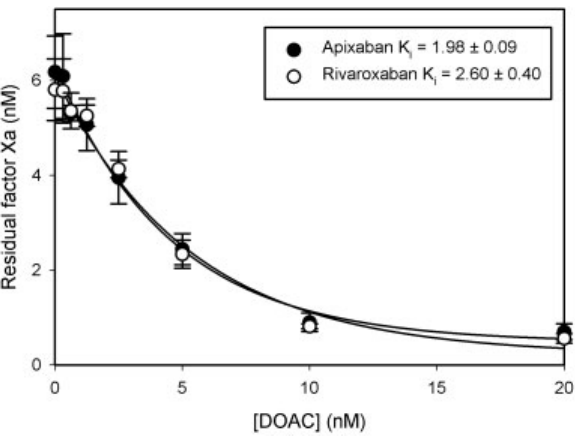
Fig. 5 Inhibition of factor Xa amidolytic activity in the presence of apixaban and rivaroxaban. Cleavage of 100 µM Pefa fl uor Xa by 0.25 nM factor Xa was monitored in a fl uorescent plate reader at 2-s intervals. Reactions were performed at 37°C in HBSTC containing 2.5 nM apixaban ( closed ) or rivaroxaban ( open ). Fluorescence inten- sity values were converted to concentration of 4-amino methyl coumarin (product) and plotted versus time. Data were fi t to a mixed inhibition model (lines). The inset shows nominal residual factor Xa concentration determined from the fi tted data plotted versus